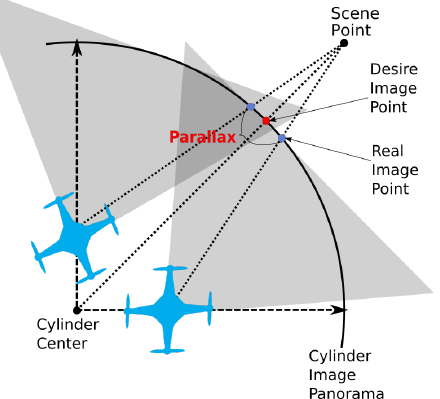
Figure 3. Parallax introduced by the discrepancy of the